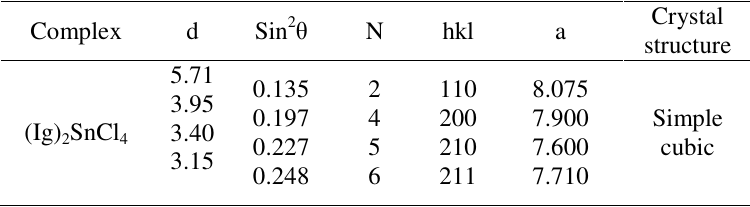
Table 5. X-ray (powder) diffraction